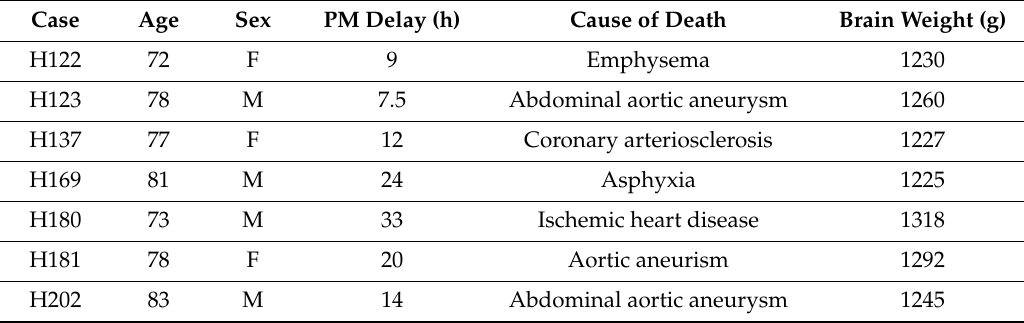
Table 3. Details of control cases for fluorescence immunohistochemistry study.